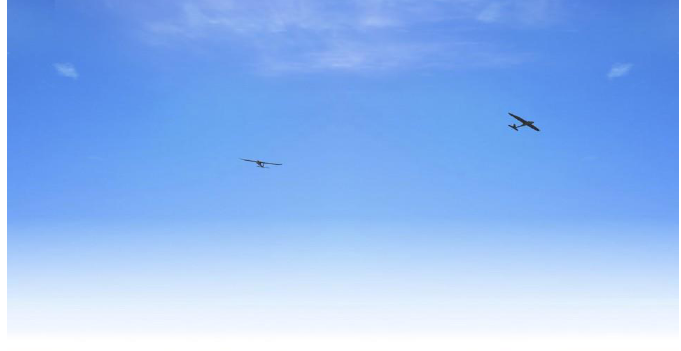
Figure 2. Synthetic image made by Blender.